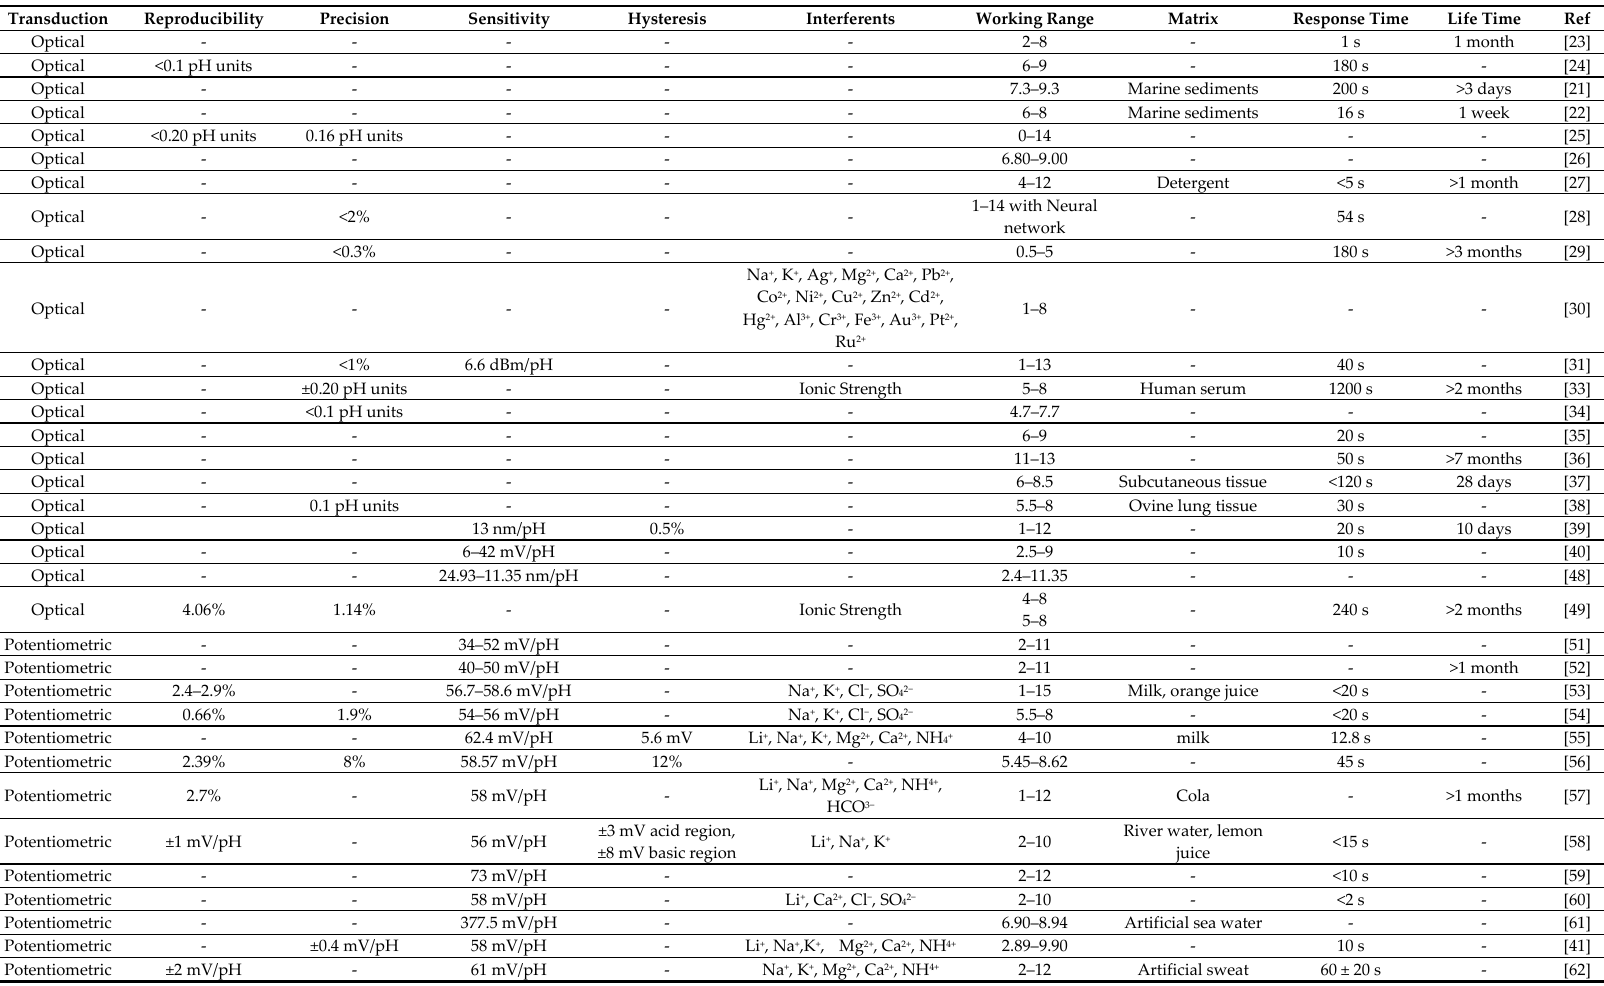
Table 1. Analytical parameters of the cited works. Reproducibility is defined as the relative standard deviation over different sensors. Precision is defined as the RSD on the same